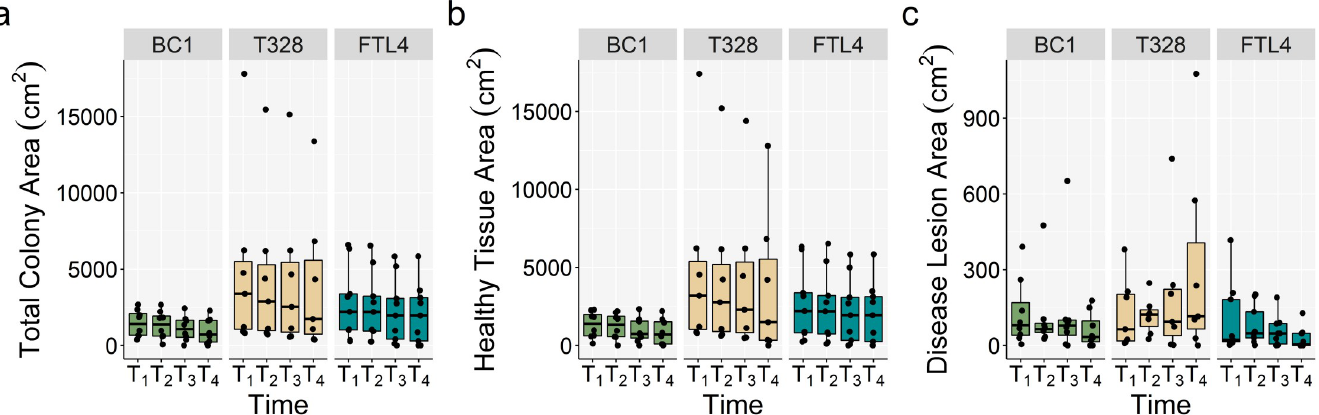
Fig 4. Comparison of tissue area through time. Mean tissue areas through time (a) mean total colony area (cm 2 ) (b) mean healthy tissue area (cm 2 ), and (c) mean disease lesion area across all sites and through time for fate-tracked M . cavernosa colonies ( n = 24). T 1 , 24-Aug-2018; T 2 , 11-Sep-2018; T 3 , 8-Nov-2018; T 4 , 17-Dec- 2018.